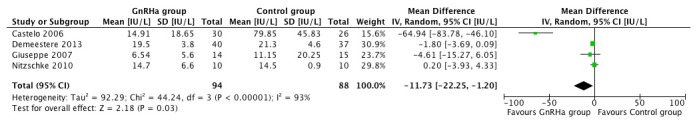
Forest plots showing FSH levels of eligible studies comparing GnRH agonists plus chemotherapy with chemotherapy alone.